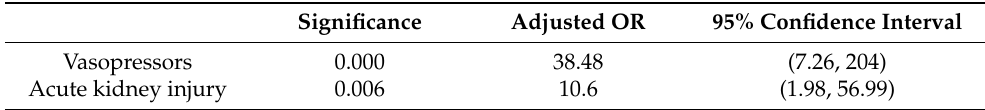
Table 4. Multivariate analysis by stepwise forward test for predicting mortality in very low birth weight